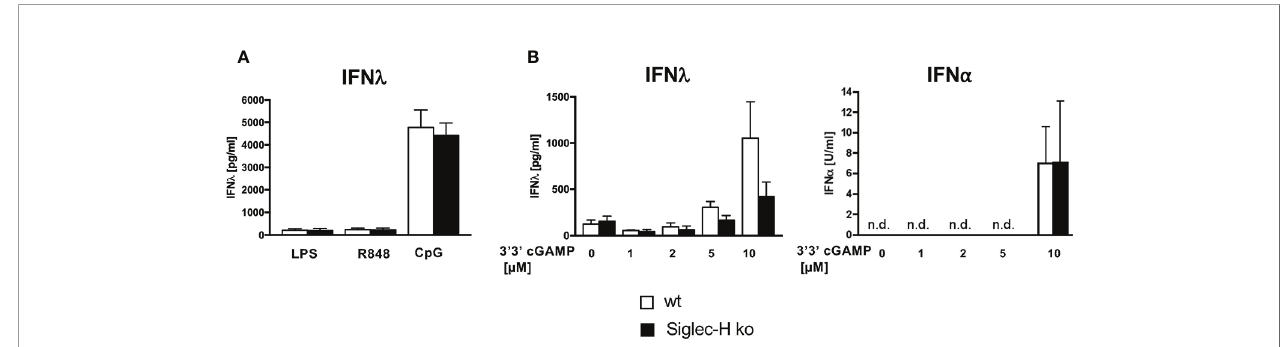
FIGURE 4 | Siglec-H de fi ciency has no in fl uence on the production of IFN- l . In vitro generated pDCs were stimulated with different stimuli for 24 hrs and supernatants were analysed via ELISA for IFN- l and IFN- a . (A) in vitro generated pDCs stimulated with LPS (c=1 µg/ml), R848 (c=4 µg/ml) or CpG (c=2,5 µg/ml) for 24hrs. The amount of IFN- l was measured via ELISA (R&D Systems). (B) In vitro generated pDCs were stimulated with different concentrations of 3 ’ 3 ’ -cGAMP and amounts of both IFN- l and IFN- ⍺ were measured via ELISA. White bars: wt, black bars: Siglec-H ko. Summary of three independent experiments, n.d., not detectable. N=5-7 mice per genotype. Error bars are mean ± SD